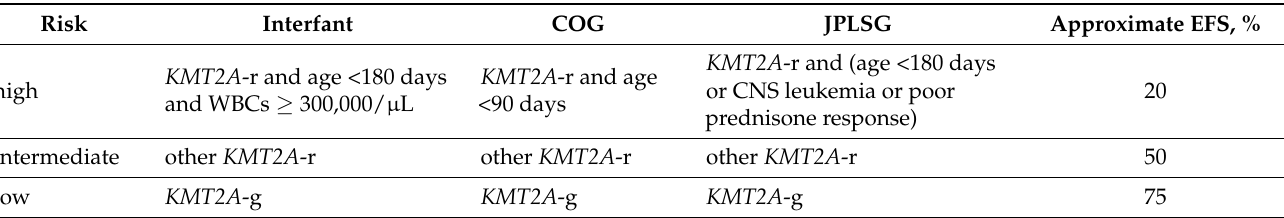
Table 2. Risk stratification in infants with KMT2A